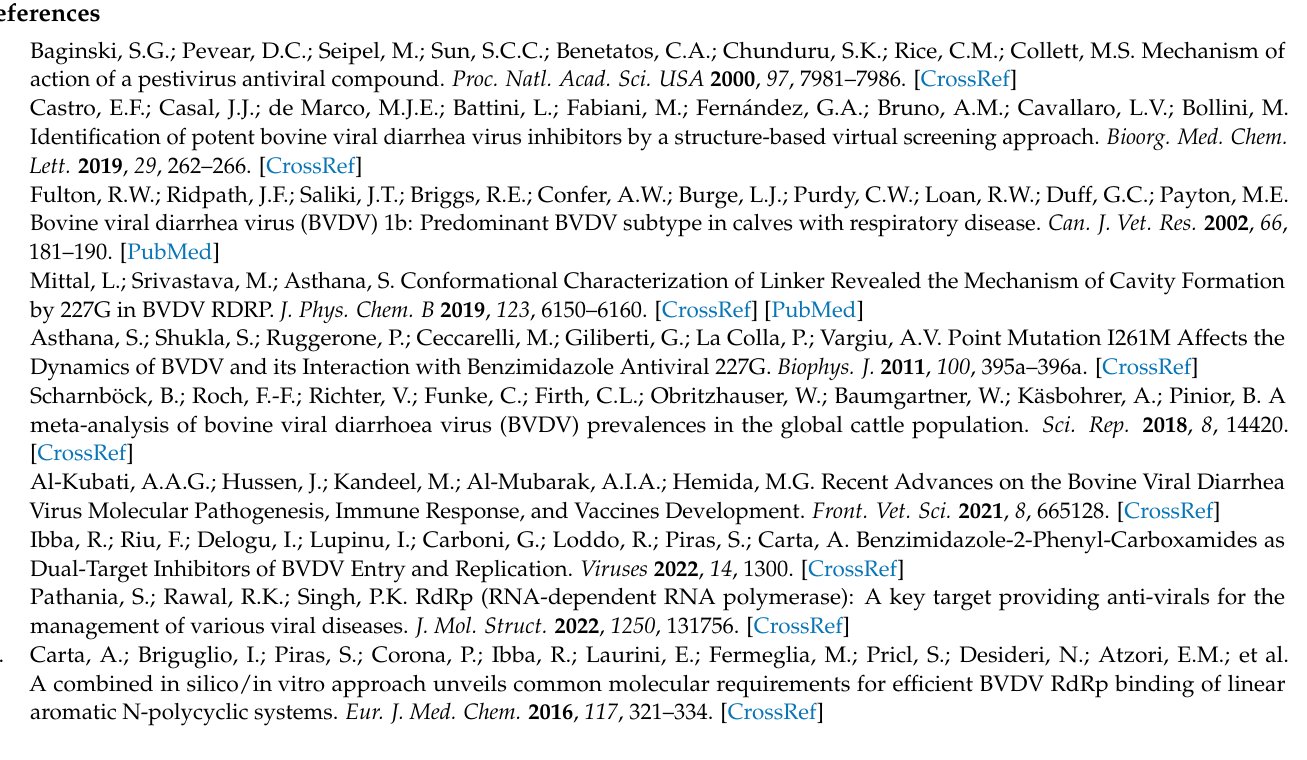
yellow. Figure S2: Blind docking reveals the clusters of (A) 2h and (B) 5m. The conformations of 2h and 5m are rendered in yellow. Figure S3: The focused ensemble-based docking (FD) on each conformer of protein, targeting the top five consensus sites identified through AL and BD steps. In particular, the top three sites showed considerable binding affinity. The top three clusters of proteins (shown in inset) were used for subsequent MD runs. Figure S4: Validation of binding pose of 2h, identified at sites 1, 2, and 3, through MD simulation of 10 ns; Figure S5: Occlusion of NTP entry channel upon binding of (A) 2h and (B) 5m. Figure S6: Electrostatic potential surface of (A) wild 2h and (B) mutant 2h. Figure S7: Mutational analysis on